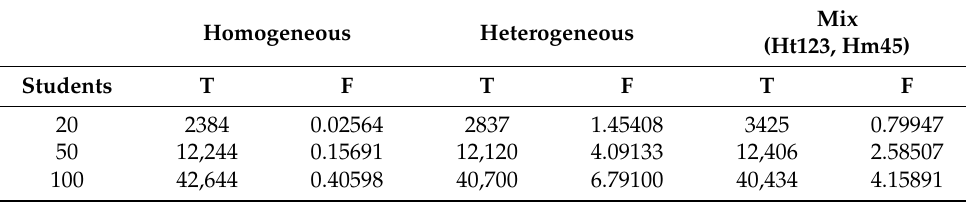
Table 9. Results of the 4-student group formation (time (T) in milliseconds, fitness value